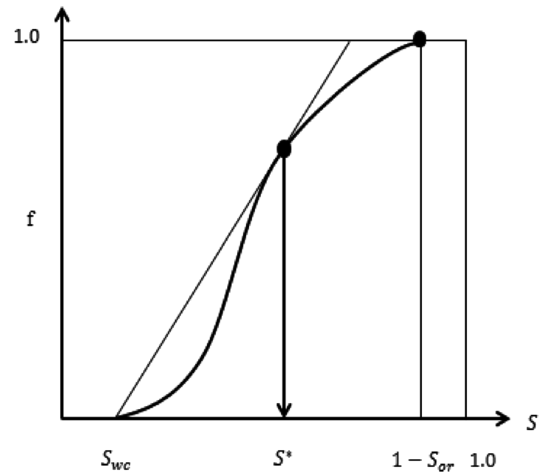
Fig. 12 Determining the front water saturation